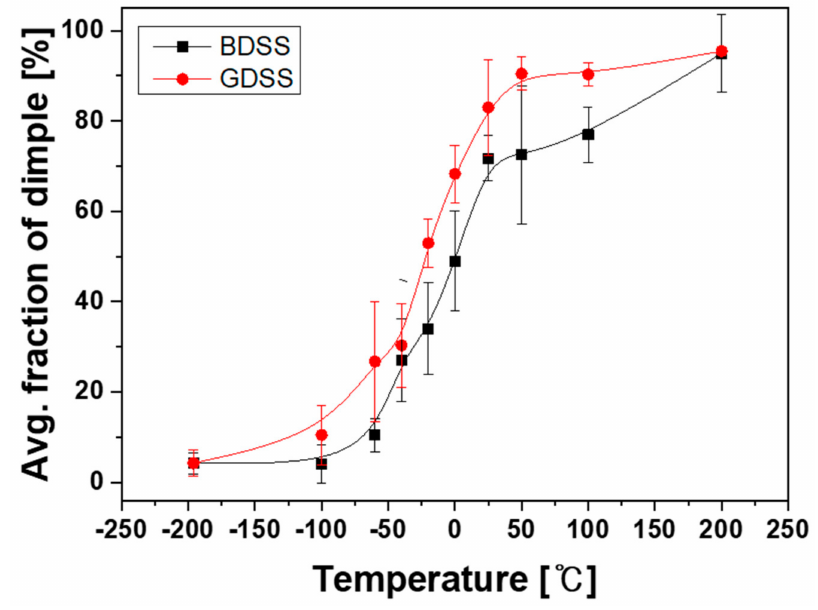
Figure 10. The average fraction of ductile fracture obtained from fracture surfaces of BDSS and GDSS at various